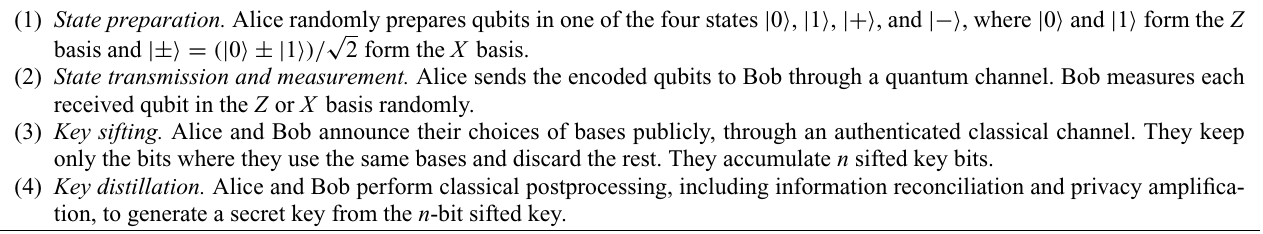
TABLE I. BB84 protocol [1], a prepare-and-measure protocol.